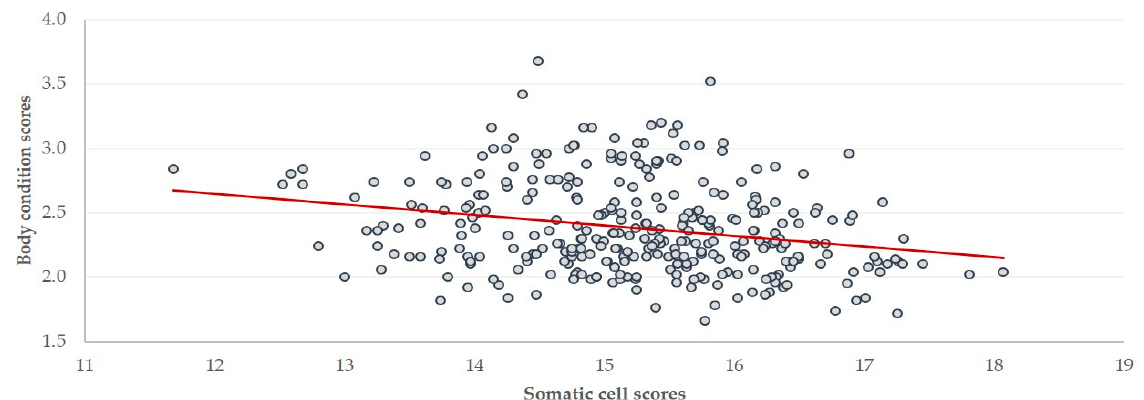
Figure 7. Somatic cell scores [log 2 (SCC/100) + 3] in the bulk-tank milk and mean body condition scores in 325 sheep flocks in Greece (straight line: tendency line).